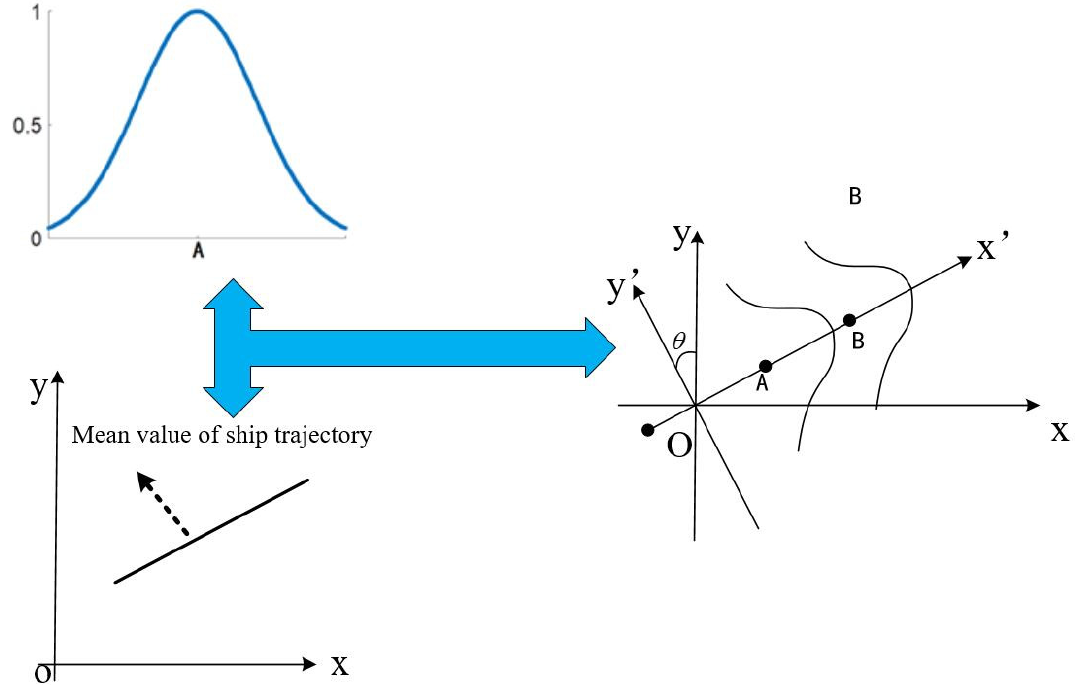
Figure 5. Trajectory of the generation of SRS images. On the basis of mean value of ship trajectory, Gaussian distribution parameters are added to obtain the navigation trajectory of the simulation ship of the SRS images.